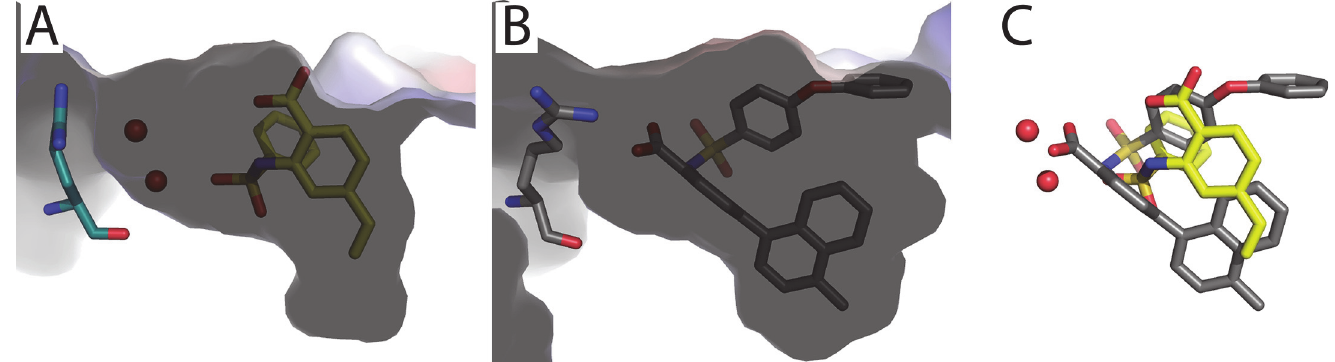
Fig 8. Structure of MBP-MCL1 bound to fragment 6 determined at 2.0 Å . (A) The surface side-view shows that fragment 6 shifts and makes water mediated hydrogen bond contacts with the peptide backbone of R263. (B) The elaborated ligand of fragment 6 (PDB ID 4OQ5) shifts to allow the methyl- naphthalene to bind in the hydrophobic pocket, requiring the carboxylic acid to make a single hydrogen bond with the sidechain of R263. (C) Overlay of crystallized fragment 6 and the elaborated ligand in PDB ID 4OQ5 reveals a distinct binding pose for 6